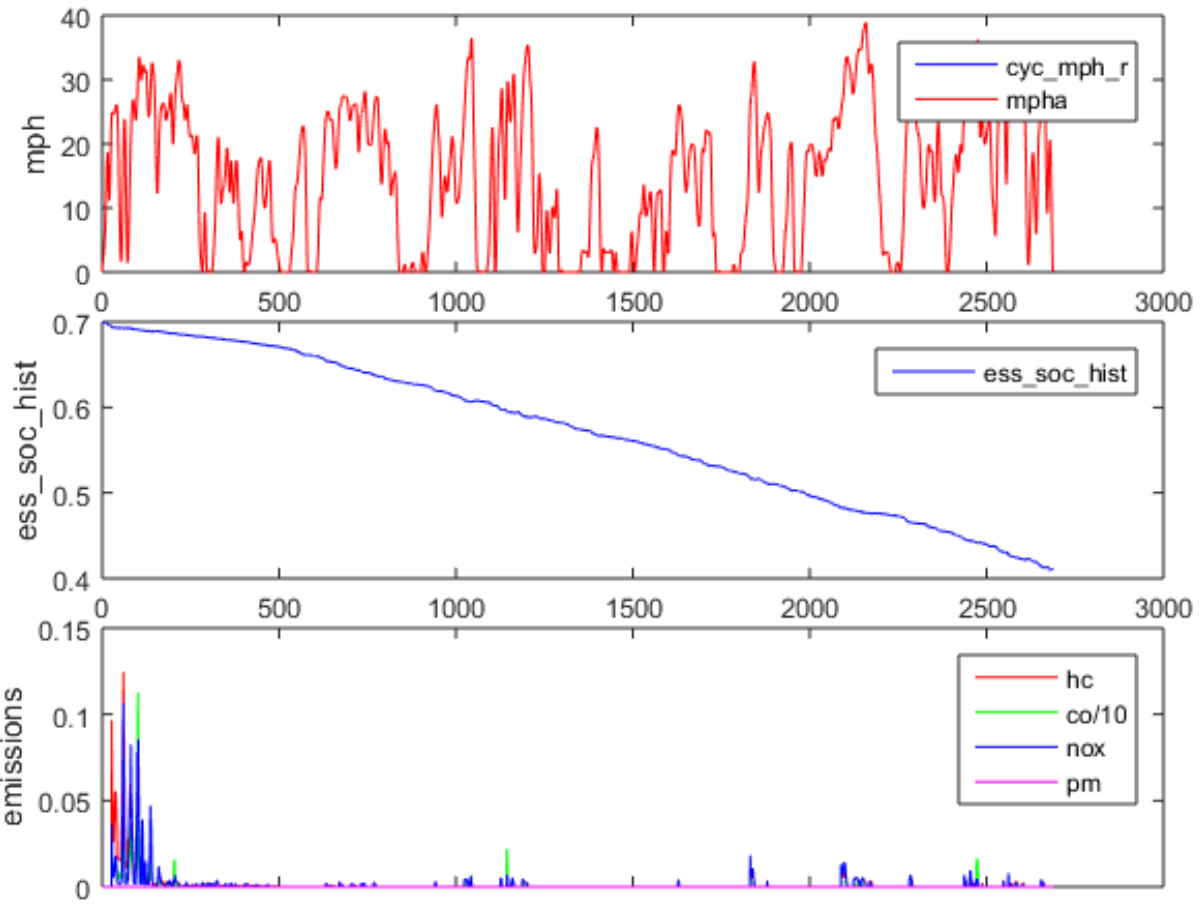
Figure 13. SOC and emissions after optimization.